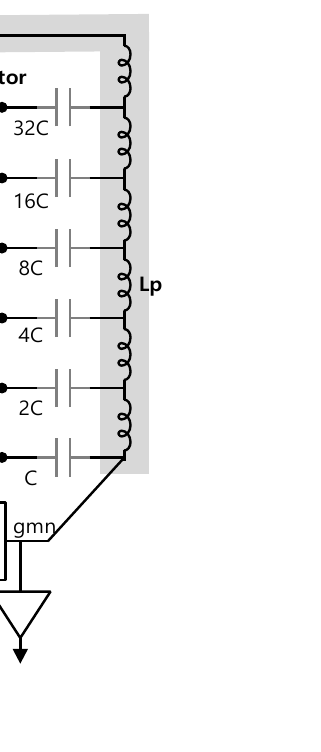
Figure 2. Equivalent circuit of a DCO including parasitic line inductance (L p ): ( a ) g m cell is located in tail of the capacitor bank; ( b ) g m cell is located in the neck of the inductor.